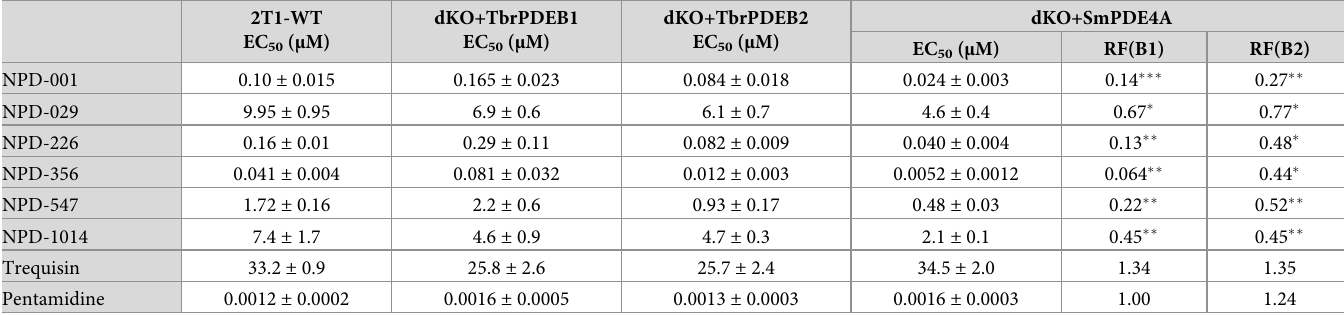
Table 3. Effects of potential PDE inhibitors on parental T . brucei 2T1 strain and on trypanosomes dependent only on TbrPDEB1, TbrPDEB2 or